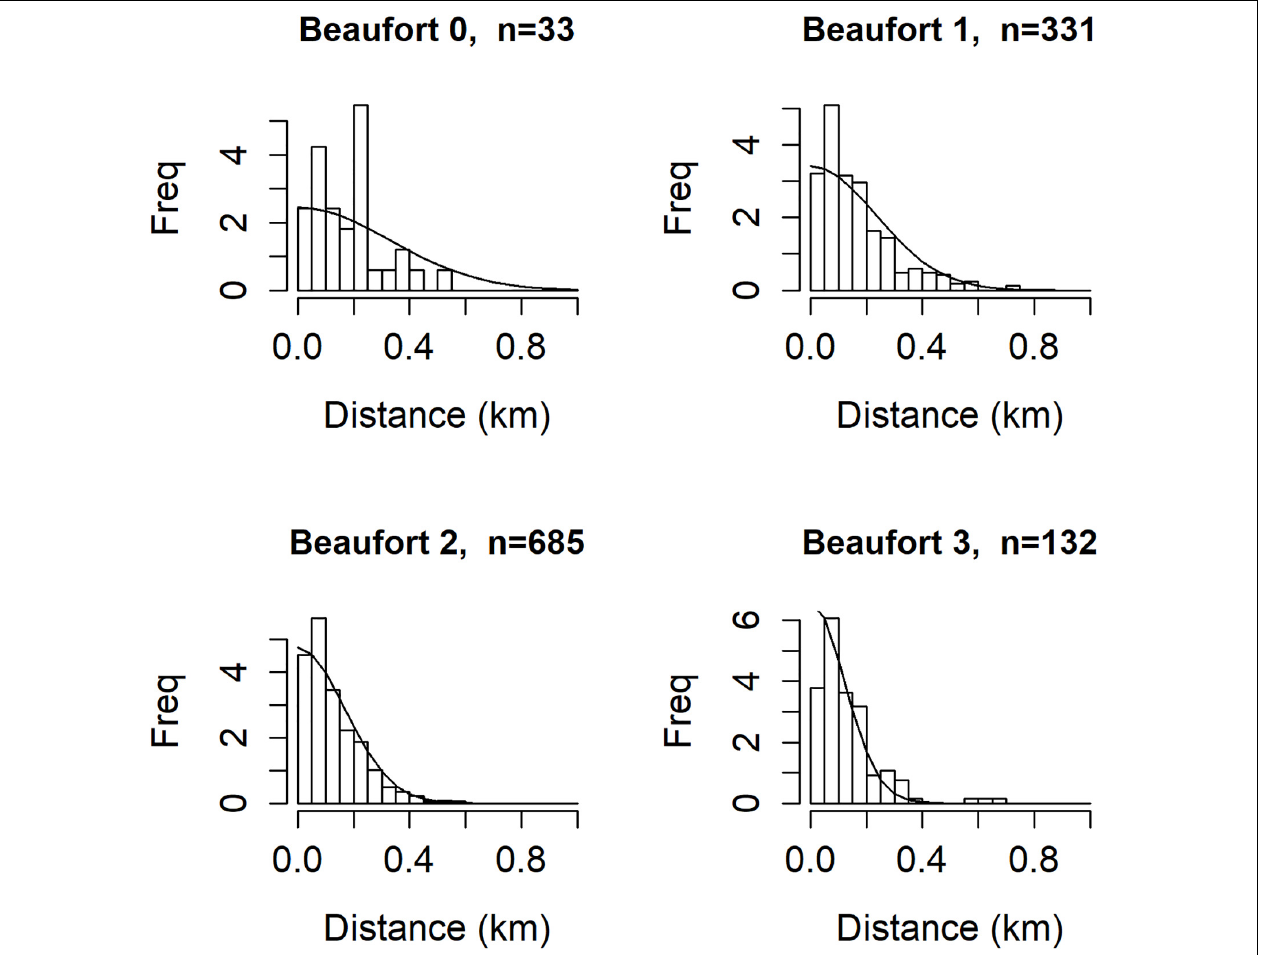
FIGURE 5 | Histograms of sighting distances for n = 1181 sightings included in the analysis, by Beaufort state. Smooth lines are the probability density functions (half normal model) for g ( x ), i.e., f ( x